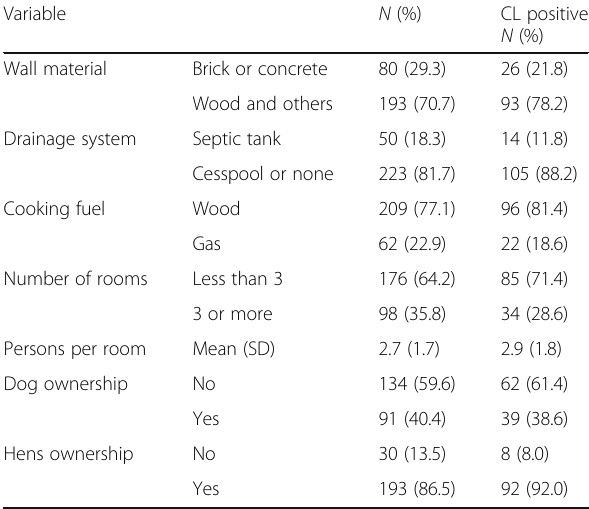
Table 2 Housing conditions of the participants expressed in percentages, Villa Tunari